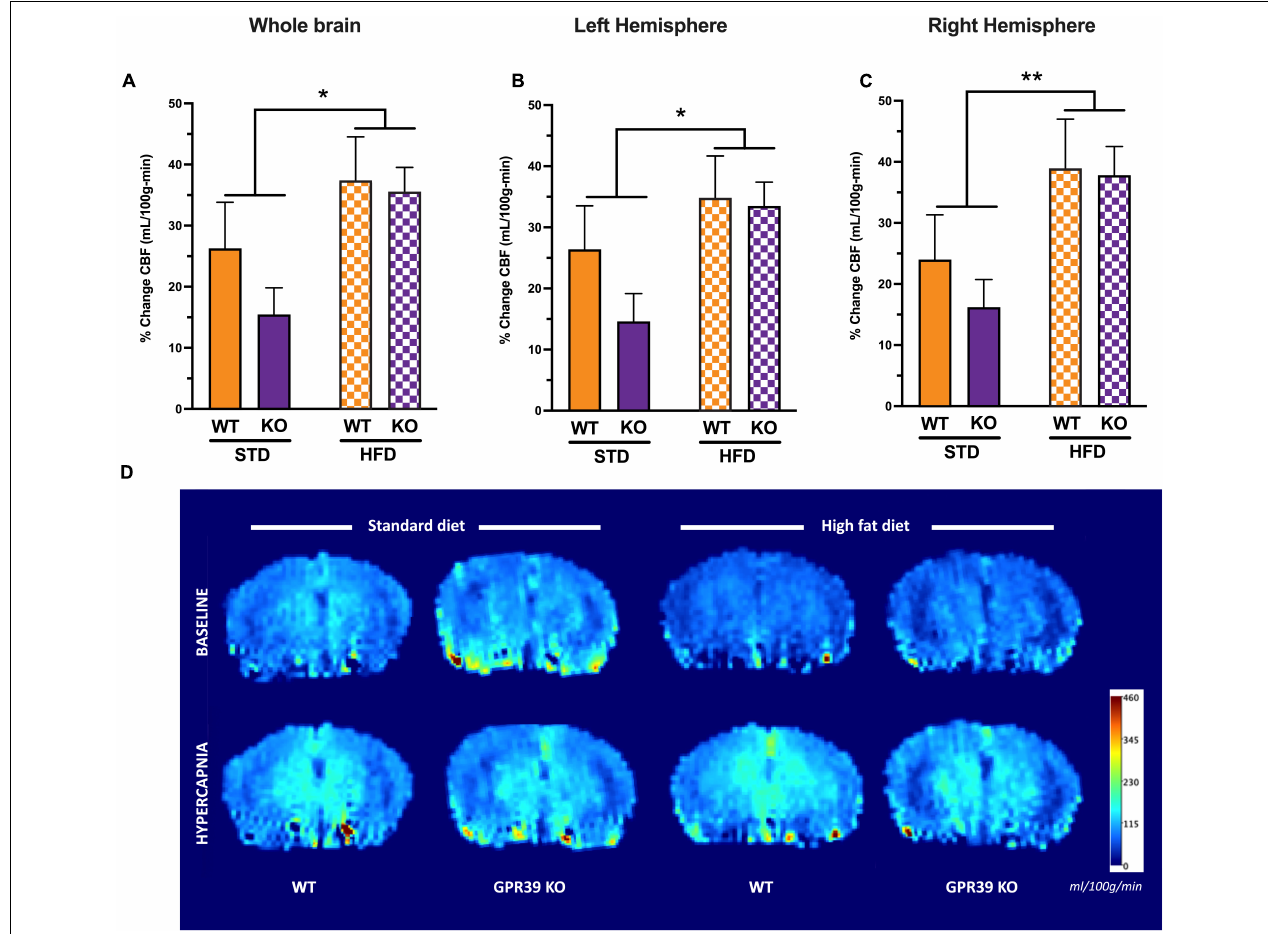
FIGURE 5 | Effects of GPR39 deficiency on cerebrovascular reactivity. (A–C) Cerebrovascular reactivity to CO 2 challenge showed a diet effect without genotype effect for the whole brain and for both brain hemispheres with a trend toward higher CBF in HFD fed mice compared to STD mice. (D) Grouped color perfusion maps of cerebral blood flow (mL/100g/min) showing reduced CBF associated with HFD. All values represent means ± standard error of the mean, * p < 0.05, ** p < 0.001, n = 4–7 per